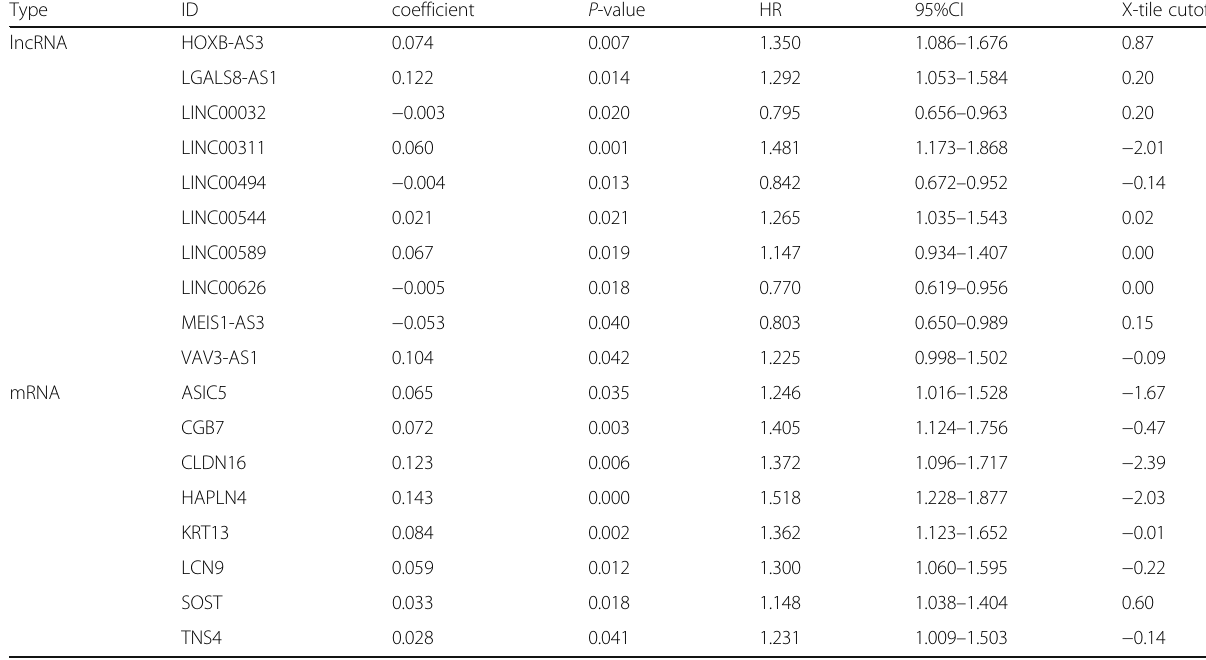
Table 1 Ten lncRNAs and eight mRNAs selected as prognostic RNAs